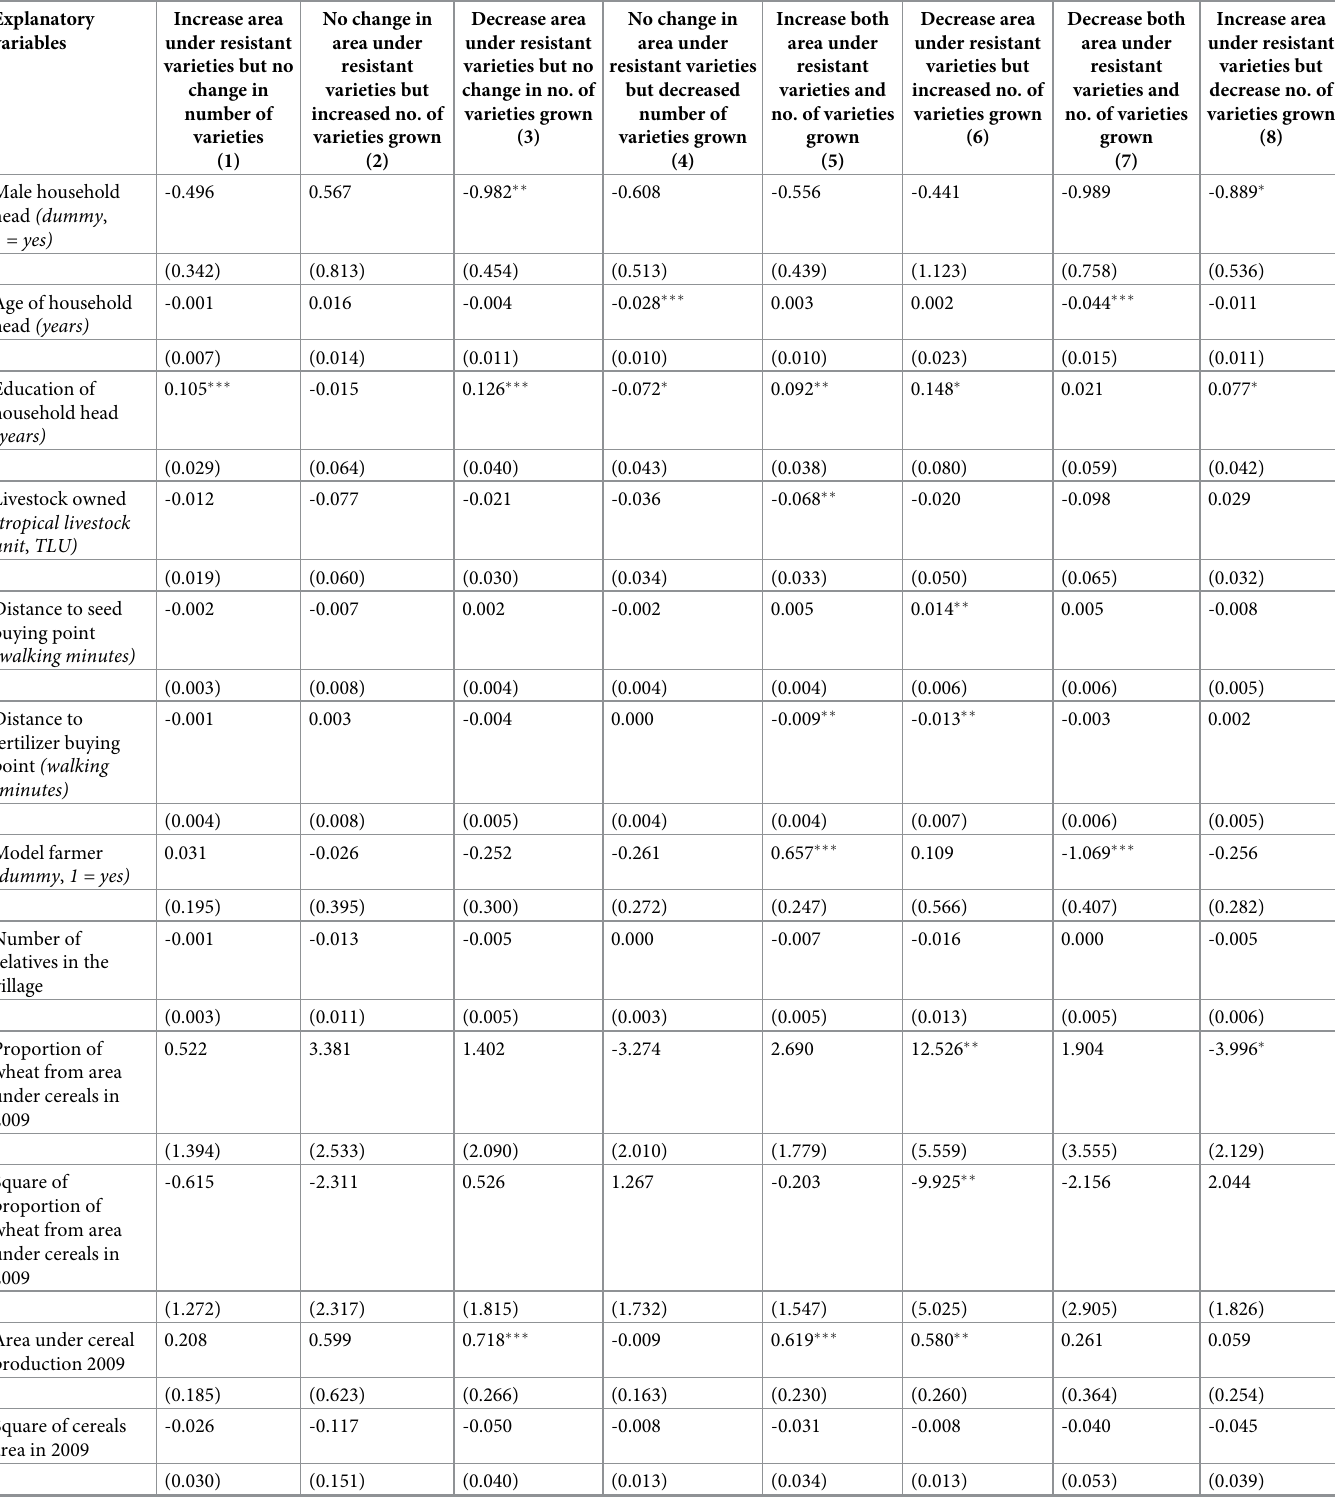
Table 7. Estimated functions explaining wheat rust coping mechanisms use, Ethiopia (Multinomial logit model, whole sample). Explanatory